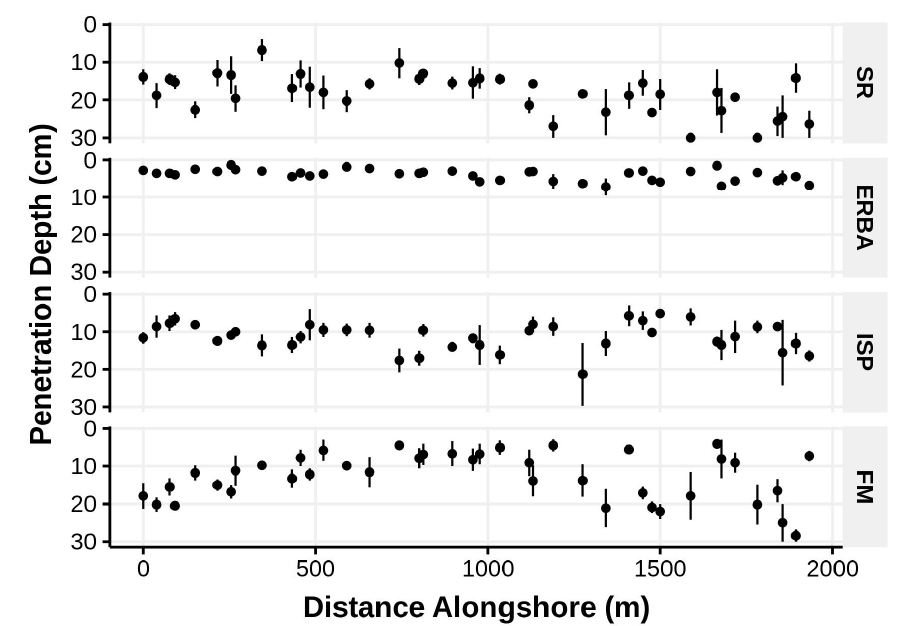
Figure 6. Mean ( ± 1 standard error) vertical sediment penetrability of low intertidal sediments at random intervals alongshore several Bogue Banks beaches in June of 2006 (beach codes same as in Figure 1).